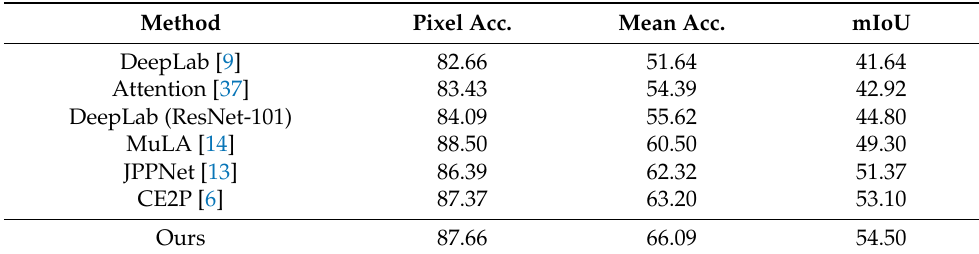
Table 1. Comparison of different methods on the validation set of the LIP dataset. Method Pixel Acc. Mean Acc. mIoU DeepLab [9] 82.66 51.64